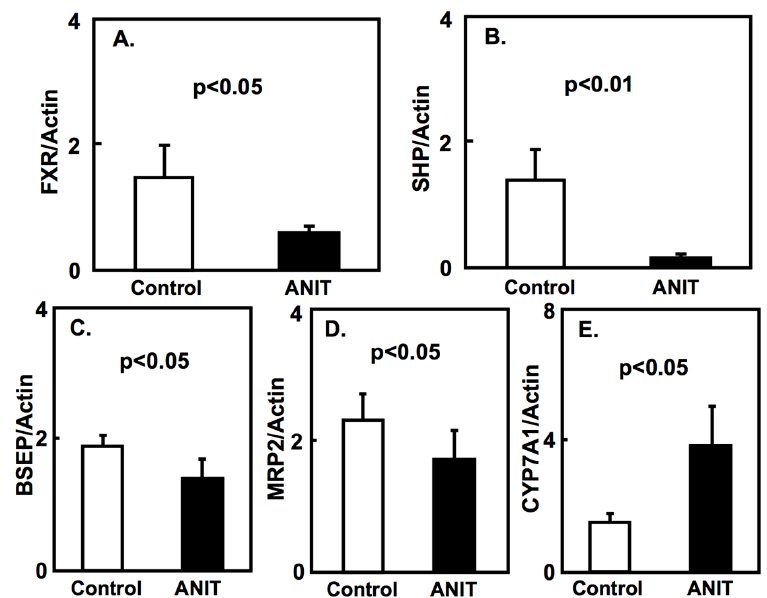
Figure 2. Hepatic expression of FXR, SHP, BSEP, MRP2, and CYP7A1 in both control and ANIT rats. Hepatic mRNA levels of FXR ( A ), SHP ( B ), BSEP ( C ), MRP2 ( D ), and CYP7A1 ( E ) in both groups ( n = 5 for each group) were examined by quantitative real-time PCR. Each bar represents the mean value ± SD and significant differences are indicated in the graph.